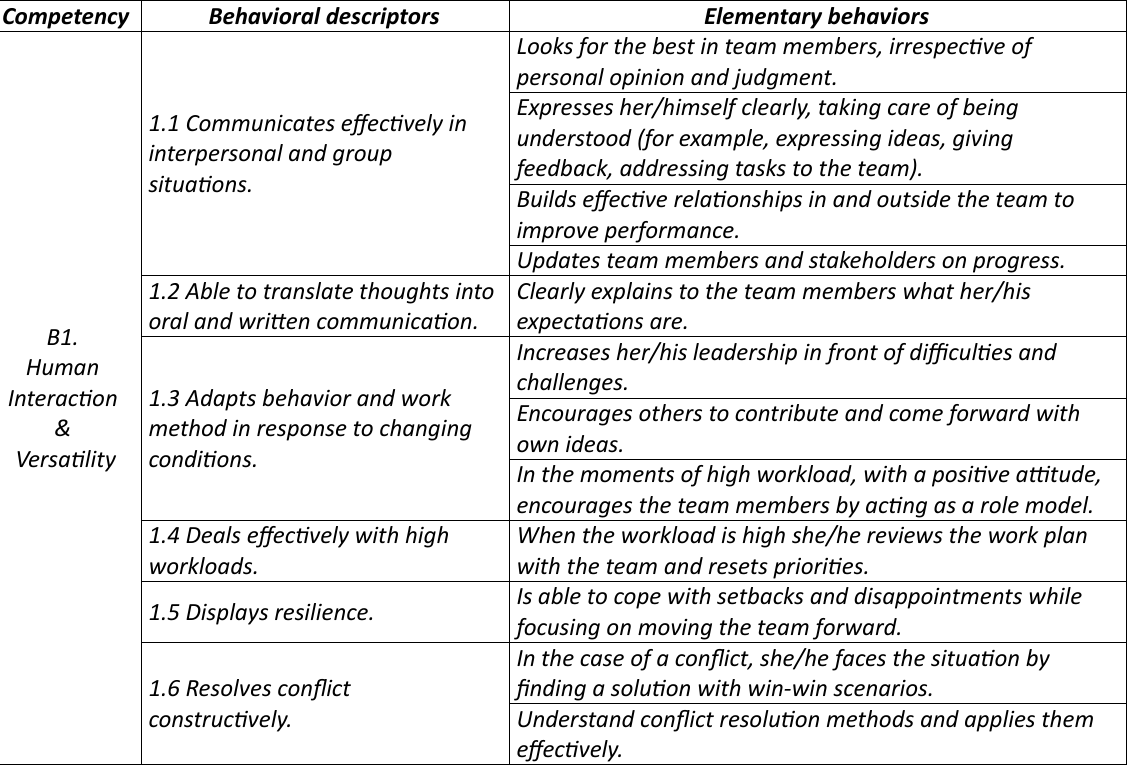
Table 2. Rubrics of the B1 competency for the leaders. The table shows the competency, the